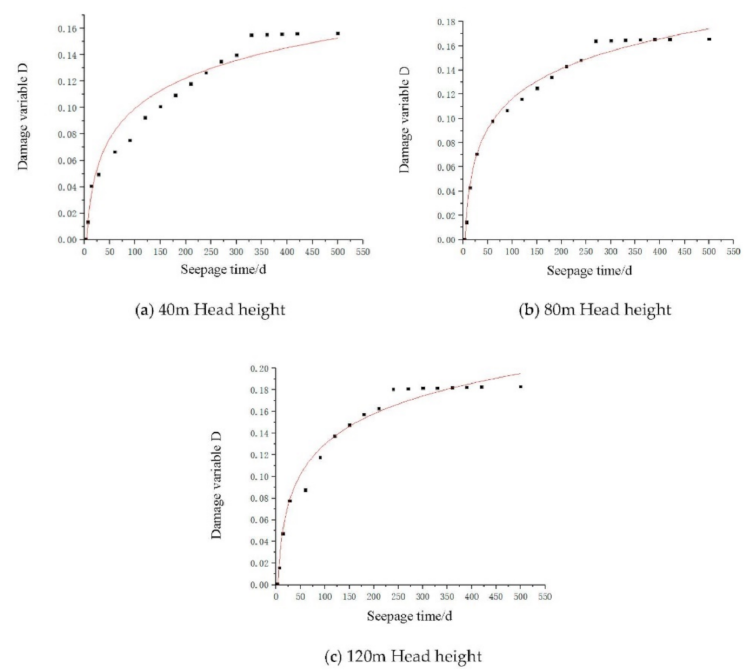
Figure 8. The relationship fitting between damage variables and